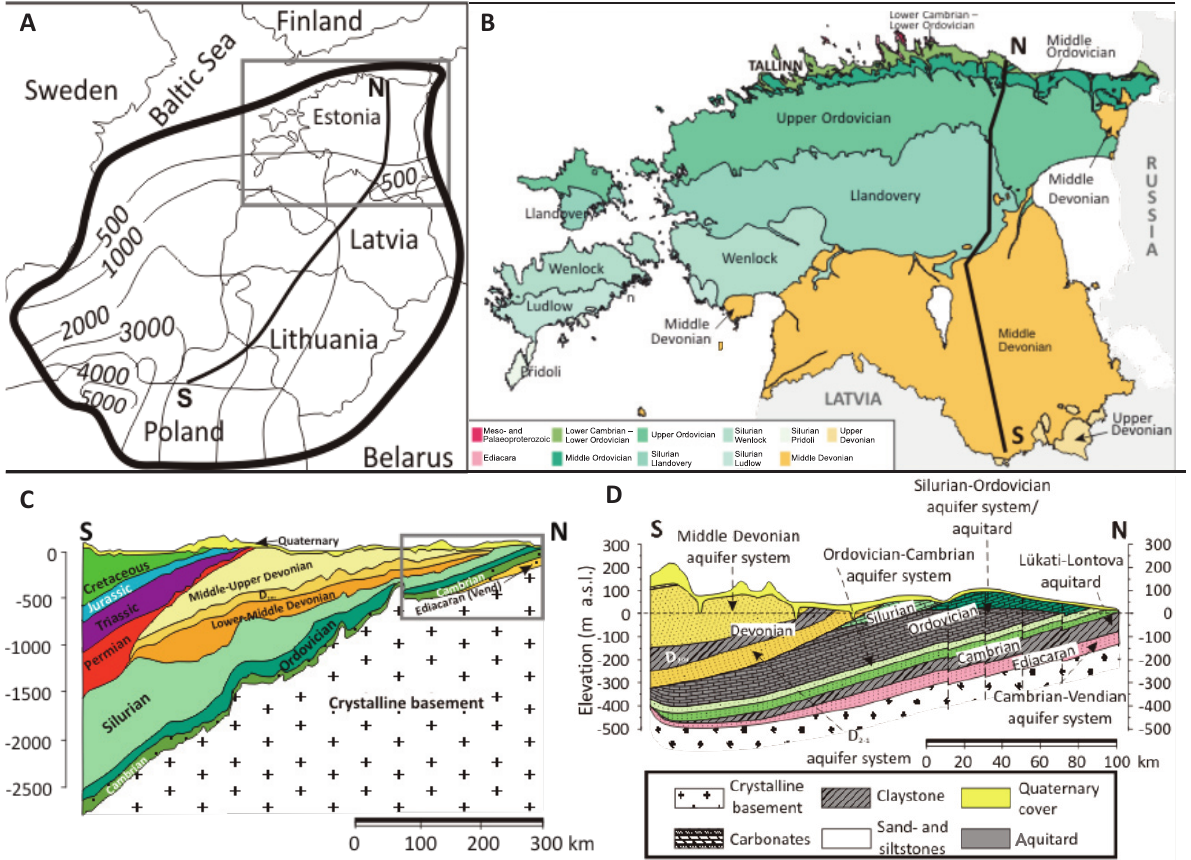
Fig. 1. A , the location and boundaries of the Baltic Artesian Basin (BAB); modified from Juodkazis (1980) and Virbulis et al. (2013). Contour lines mark the depth of the crystalline basement in metres below sea level. The geological cross-section of the BAB along the line N–S is shown in C and D . Abbreviations: D 2–1 aquifer system – Lower–Middle Devonian aquifer system, D 2nr – Narva regional aquitard, Q – Quaternary. B , the close-up (rectangle in C) depicting the geological and hydrogeological setting in the northern part of the BAB (Estonia). Modified from Pärn